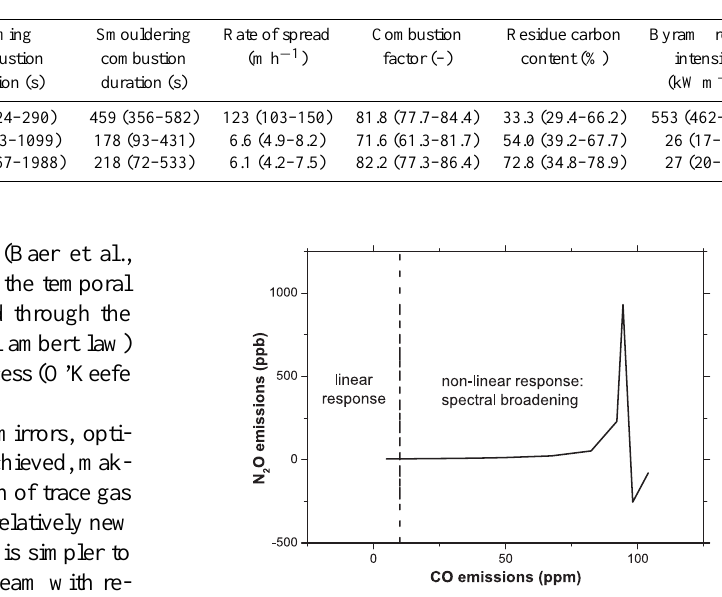
Table 1. Summary of fire behaviour data from the experiments. Values are reported as the mean with the range reported as (minimum value– maximum value). Byram fire line intensity is the product of the lower heating value of the fuel (kJkg − 1 ), fuel consumed (kgm − 2 ) and the forward rate of spread (ms − 1 ) (Byram, 1959).